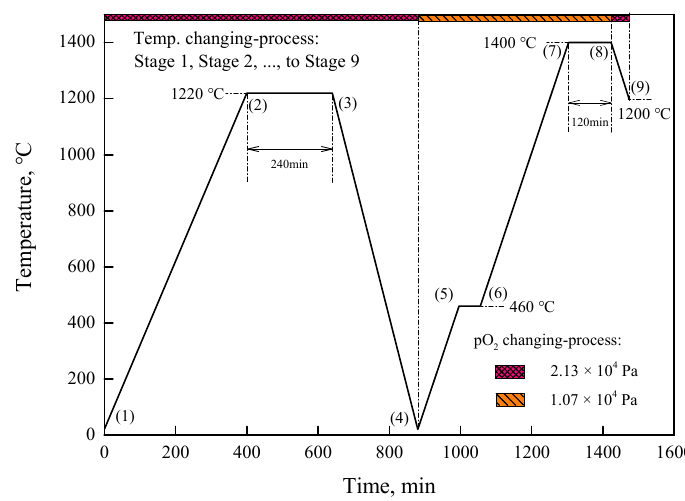
Figure 1. Changes in temperature and atmosphere in sintering process. To investigate SH formation, the preheated samples were heated with 3.8 ◦ C/min from room temperature (Stage 4) to 460 ◦ C (Stage 5), kept at 460 ◦ C for 60 min (Stage 6) to obtain a linear temperature-heating process after 460 ◦ C, raised by 3.8 ◦ C/min to 1400 ◦ C (Stage 7), and then kept at 1400 ◦ C for 120 min (Stage 8) in p O2 = 1.07 × 10 4 Pa for the transformation of hematite to magnetite. For the transformation of magnetite to